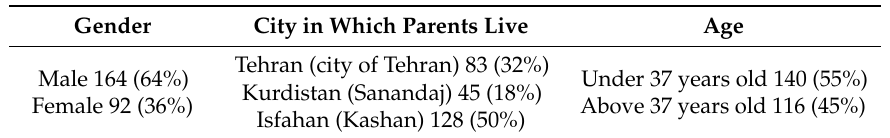
Table 1. Parents’ demographic details.